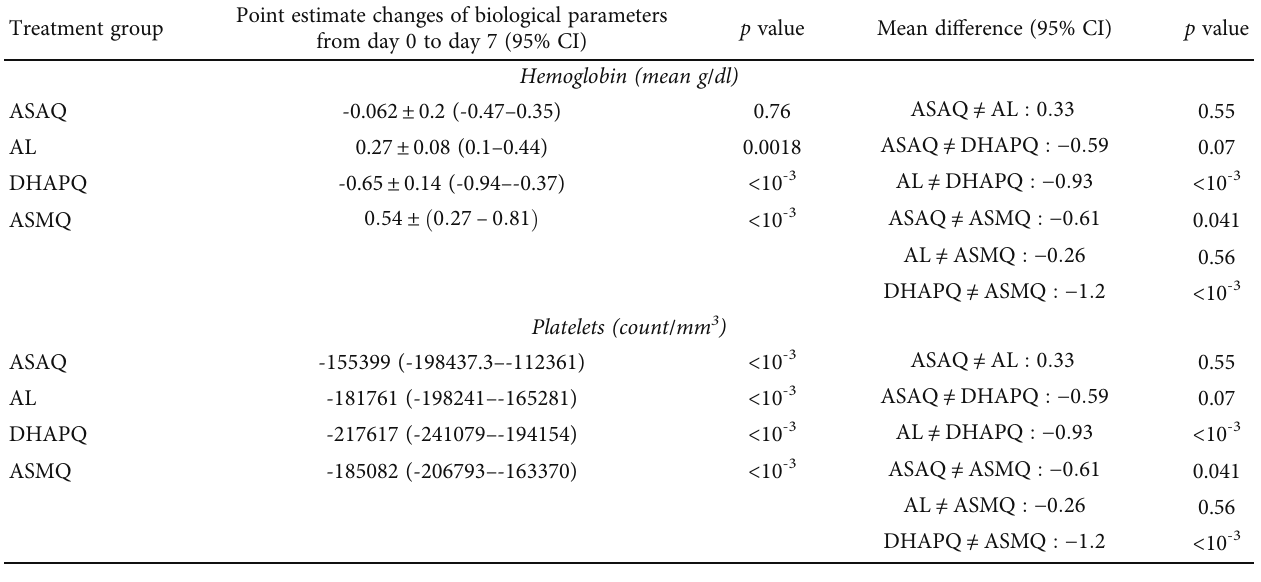
Table 4: Hemoglobin and platelets changes from day 0 to day 7 by treatment arms. Treatment group